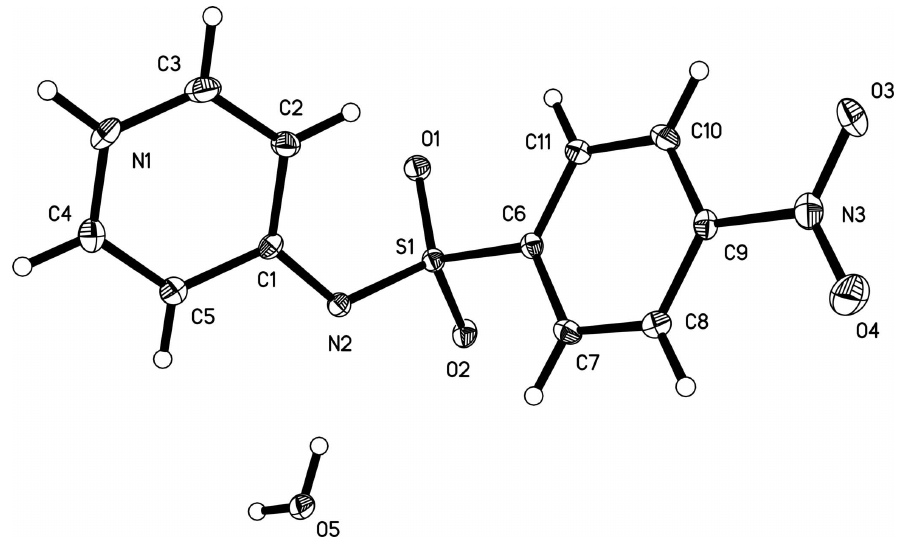
Figure 1 Molecular view of the title compound (I) showing the atom-labelling scheme. Displacement ellipsoids are drawn at the 35% probability level (arbitrary spheres for the H